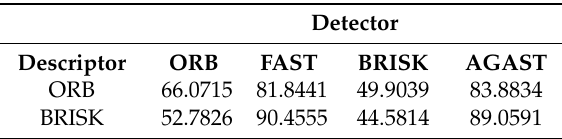
Table 3. 1- Accuracy of different combination